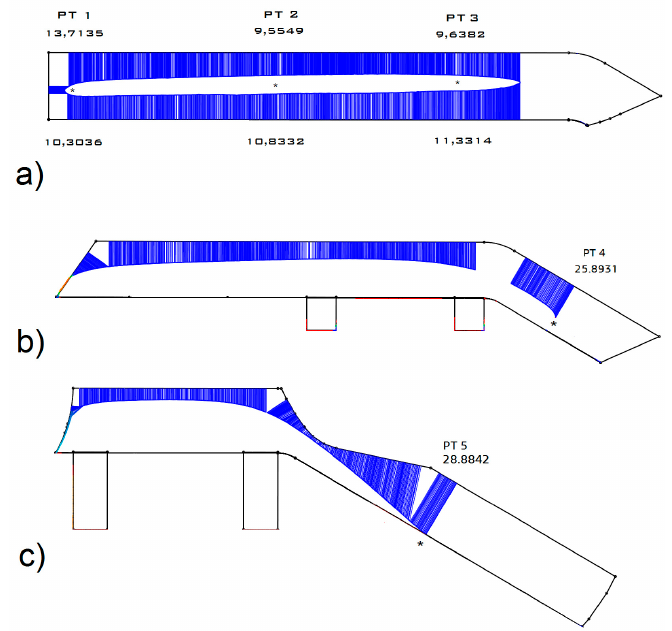
Figure 3 . Mean thickness of the worn profiles: ( a ) points 1, 2, 3; ( b ) point 4; ( c ) point 5.